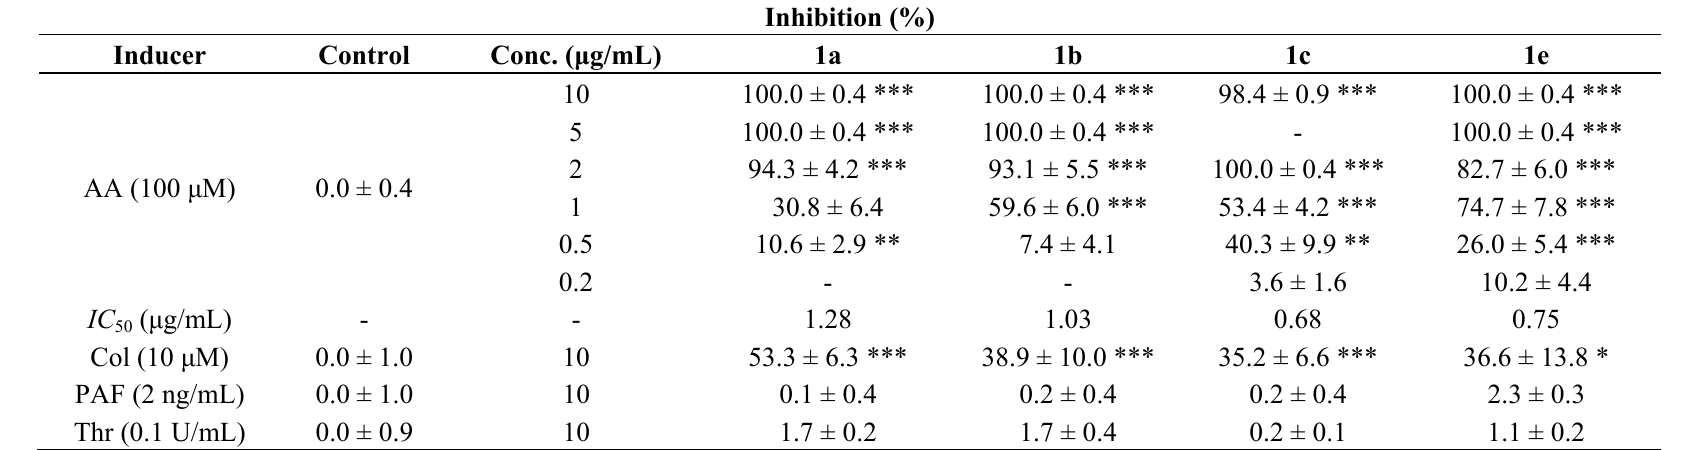
Table 12. Antiplatelet activity of [ n ]-isodehydrogingerdiones 1a – c and e .